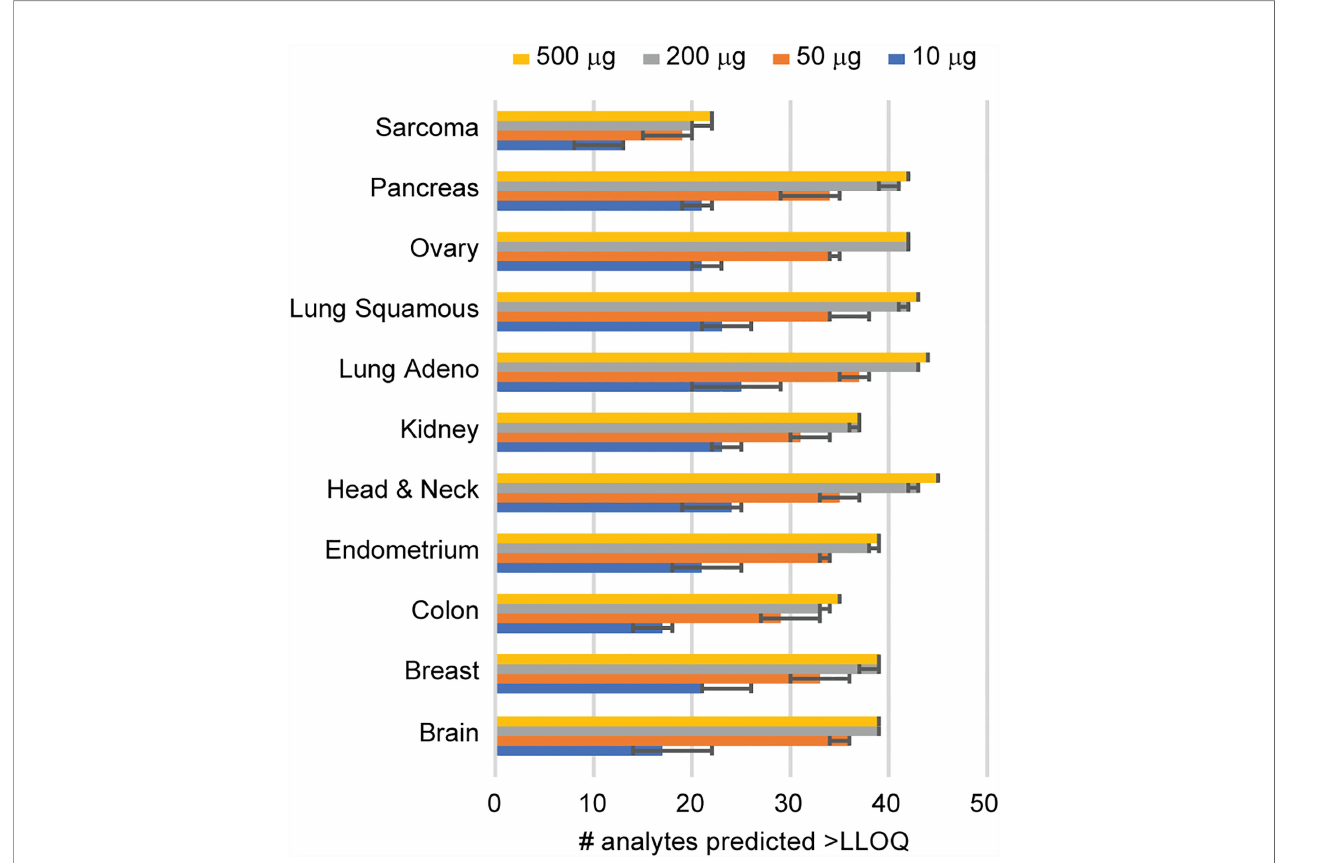
FIGURE 3 | Determination of sample requirements for detection in tissue. The number of analytes predicted for decreasing amounts of tissue was determined from the signal-to-noise ratio measured using 500 m g protein digest input. Error bars show the 95% con fi dence